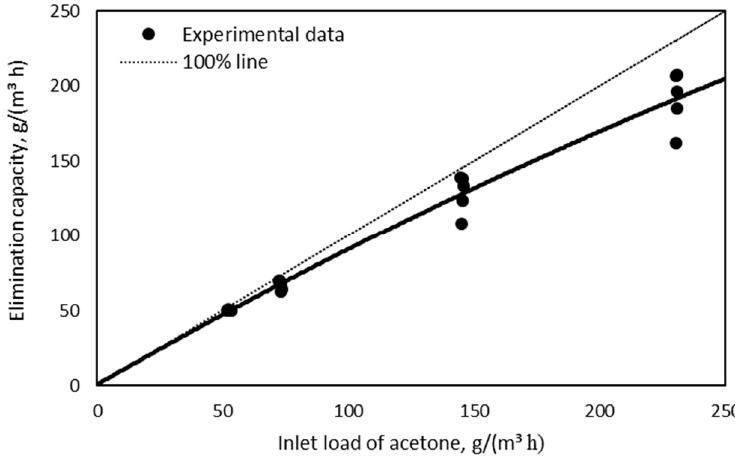
Figure 7. Influence of acetone inlet loading on the elimination capacity of the biotrickling filter.